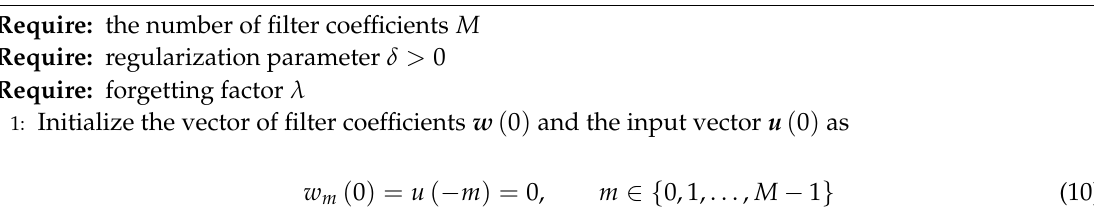
Algorithm 2 RLS adaptive algorithm.